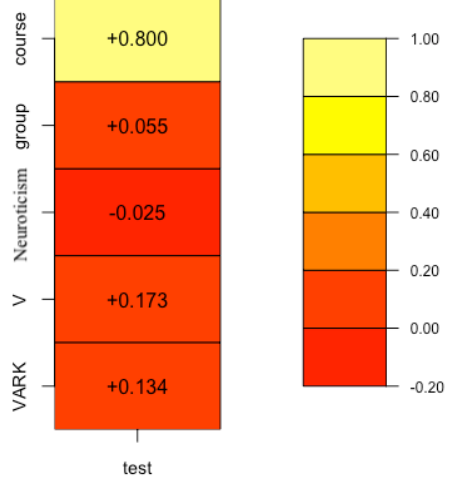
Correlation of Significance Codes for Test